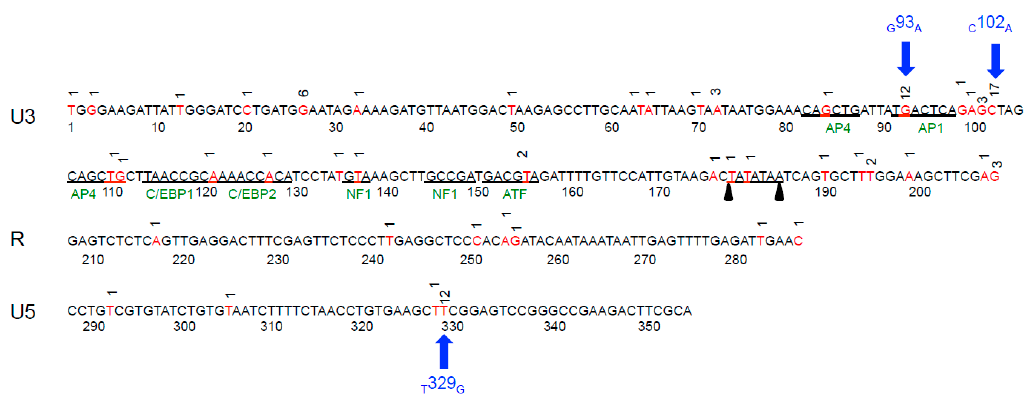
Figure 3. Summary of the FIV proviral LTR point mutations detected during the asymptomatic phase from all FIV-infected cats over time. Three SNPs were commonly detected (denoted by blue arrows). Nucleotide positions where mutations were detected are red and the number above the sequence indicates of number of times a particular mutation was detected. Known transcription factor binding sites are in green and the TATA box is underlined by black triangles.